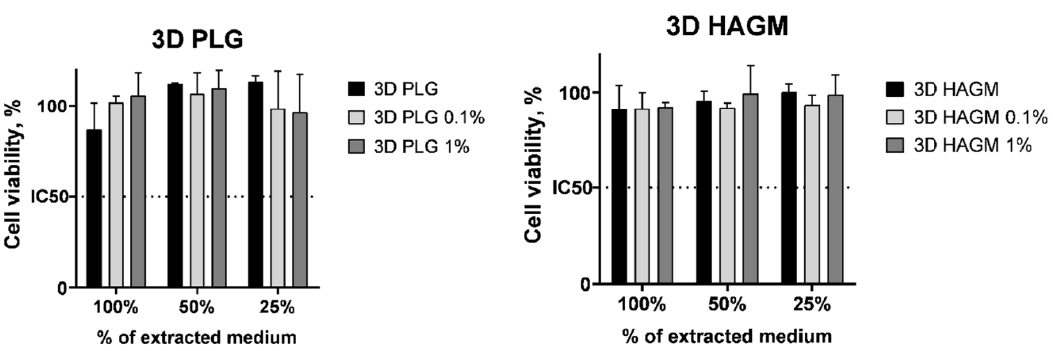
Figure 10. The viability of Bj-5ta fibroblasts in extract assay, 24 h incubation. Data are the mean ± SD; the viability of non-treated (intact) cells was taken as 100%.